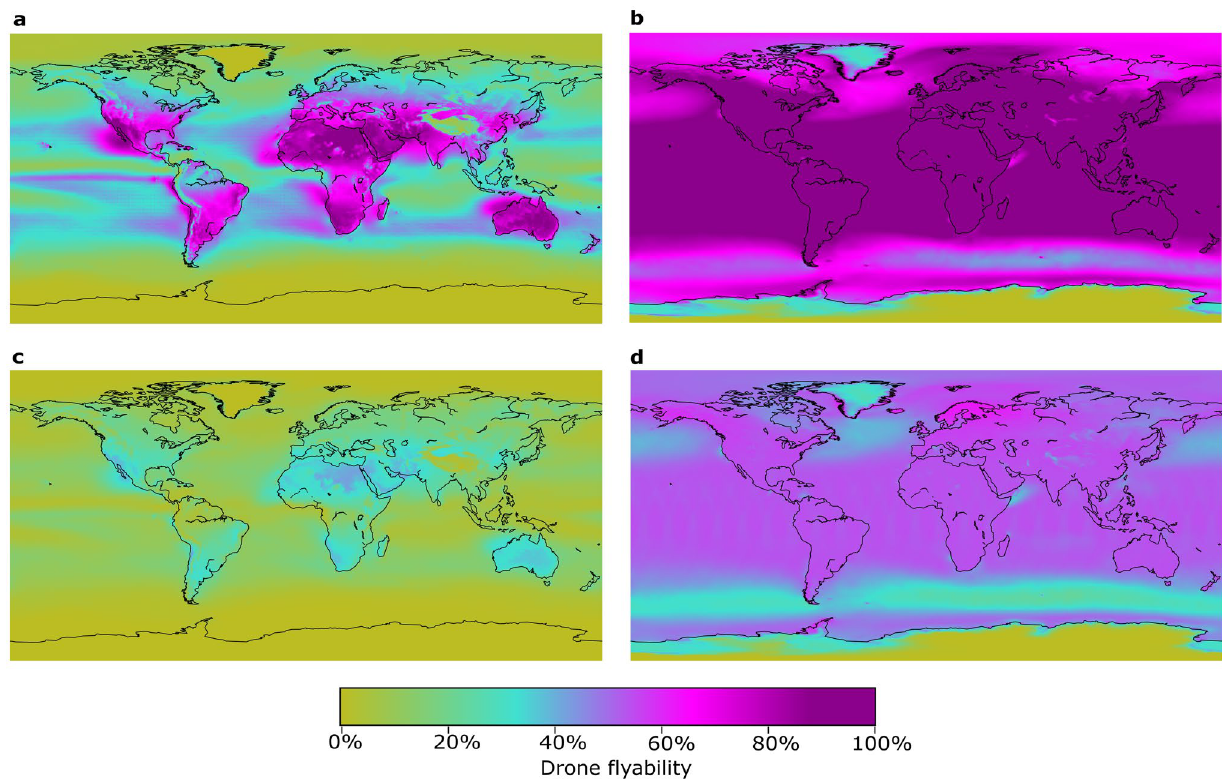
Figure 2. Global flyability: ( a ) CD in day-and-night conditions, ( b ) WRD in day-and-night conditions, ( c ) CD in daytime only conditions, and ( d ) WRD in daytime only